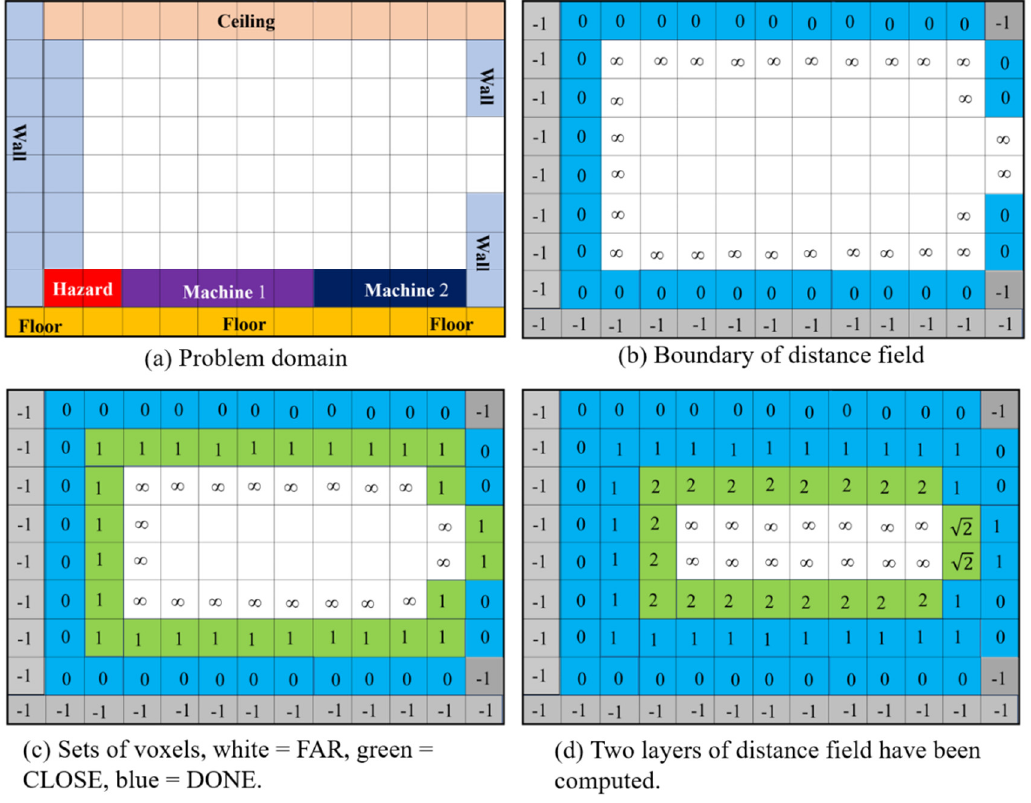
Figure 2. Distance field computation in a 2D domain, ( a ) the domain, ( b ) initial configuration and boundary condition, ( c ) the DONE, CLOSE, and FAR sets, and ( d ) partially computed distance field.